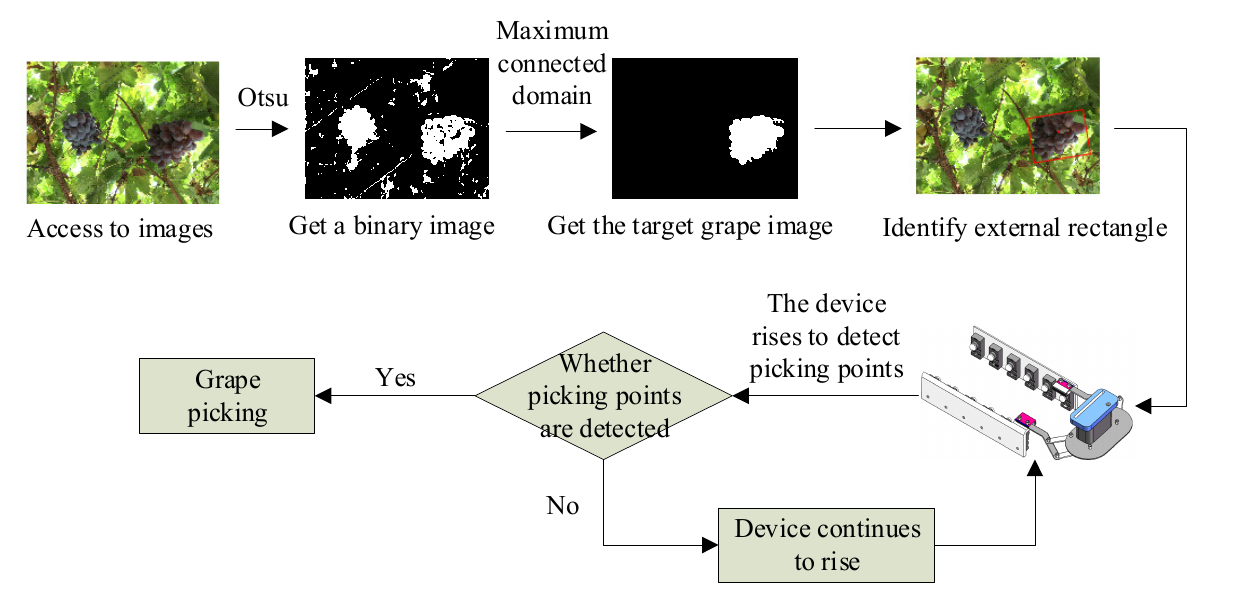
Figure 9. Flow chart of picking point location algorithm.